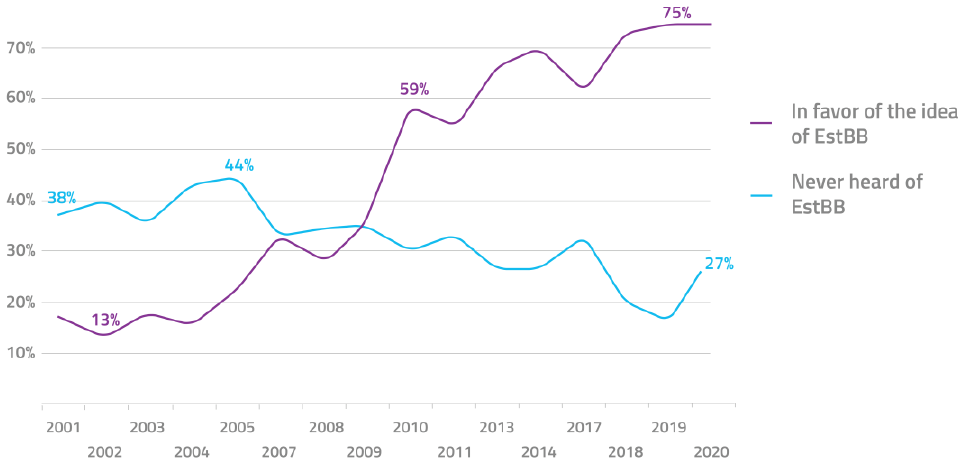
Figure 1. Public awareness and approval of the Estonian biobank over the past 2